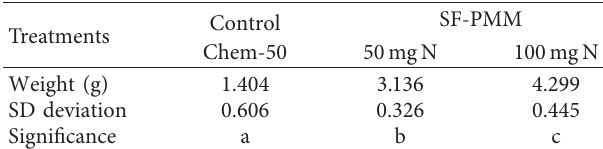
Figure 5: Effects of addition of glycine on the change of various parameters in the wastewater during incubation with the active sludge in the plastic tank. 50L of the wastewater was treated as described in Section 2.1, and 3g of glycine was added at the start of the incubation. (a) Concentrations of protein ( ) and amino acid ( ) were measured according to the description in Section 2.4.2. (b) NH 4+ concentration ( ) and pH ( ) were measured according to the methods described in Section 2.4.2. The experiment using cold glycine was done three times as mentioned in Figure 1, and the experiment of the addition of 15 N-glycine was done one time. Table 1: Effects of SF-PMM on the growth of komatsuna shoots in 5-week